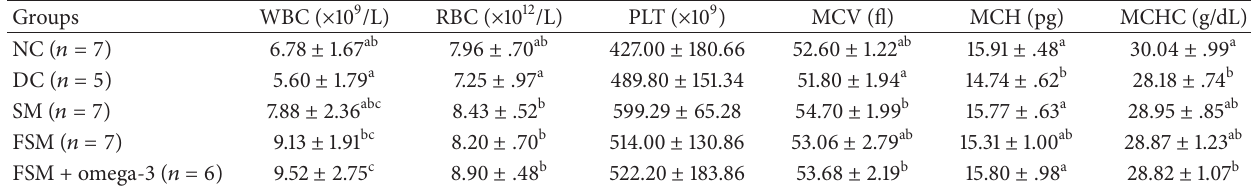
Table 4: Hematologic parameters of each group fed with different